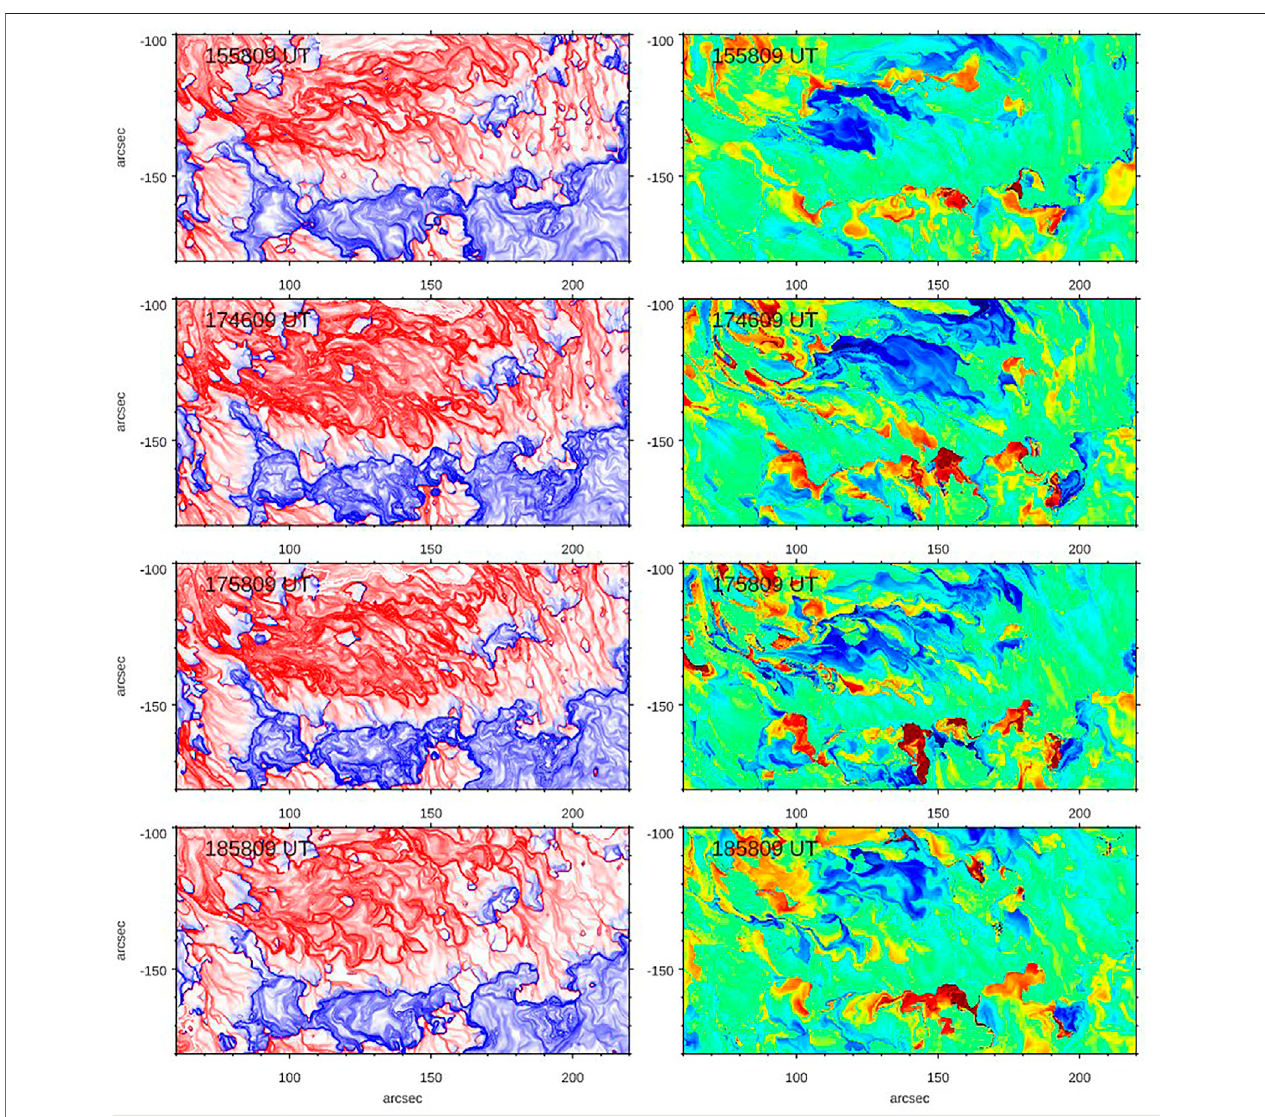
FIGURE 3 | Evolution of Q (left) and T W parameters near the fl aring PIL. Twist maps are scaled between ±2 units.